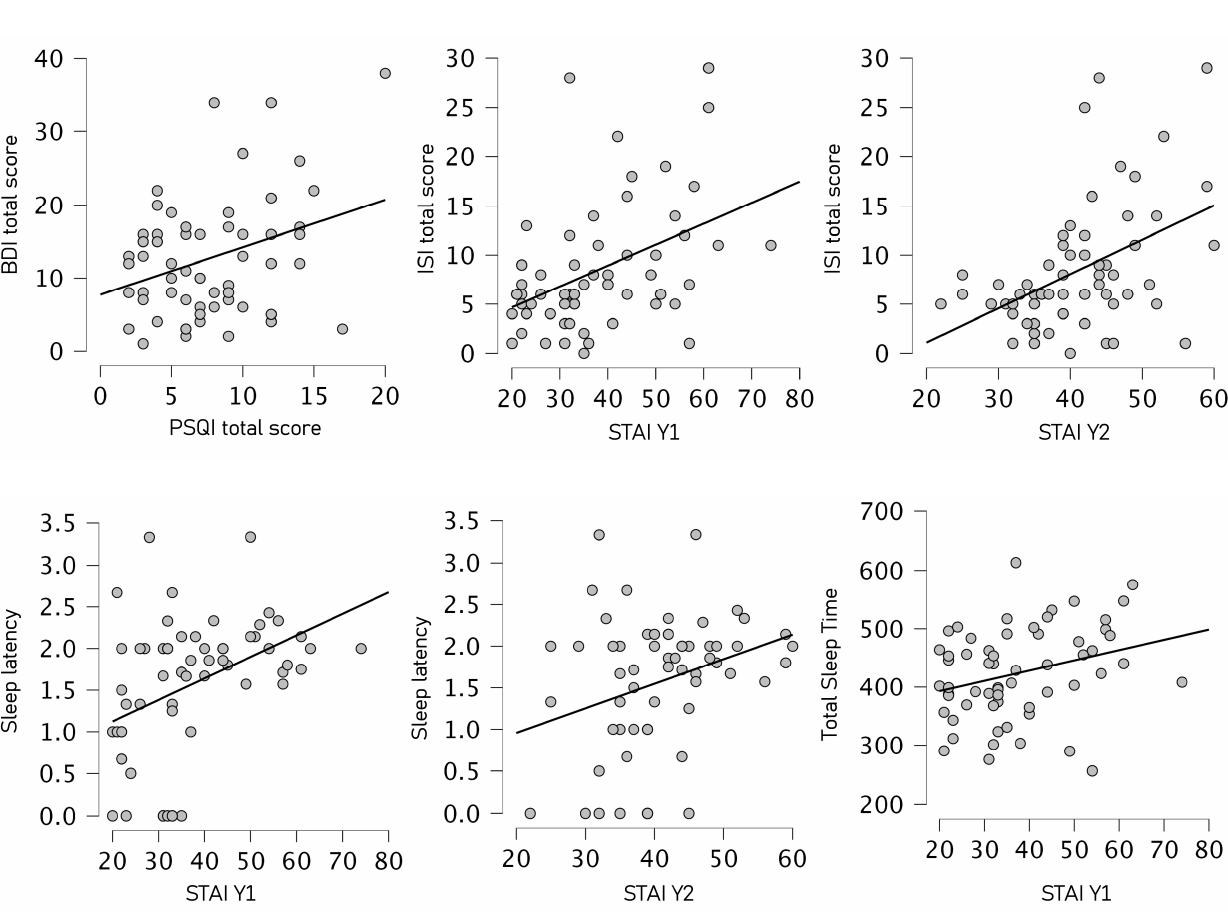
Figure 1. Correlation matrix plots between clinical variables and sleep index. Note: STAI Y1 = State-Trait Anxiety Inventory State, STAI X2 = State-Trait Anxiety Inventory Trait, BDI-2 = Beck Depression Inventory II Edition, PSQI = Pittsburgh Sleep Quality Index.